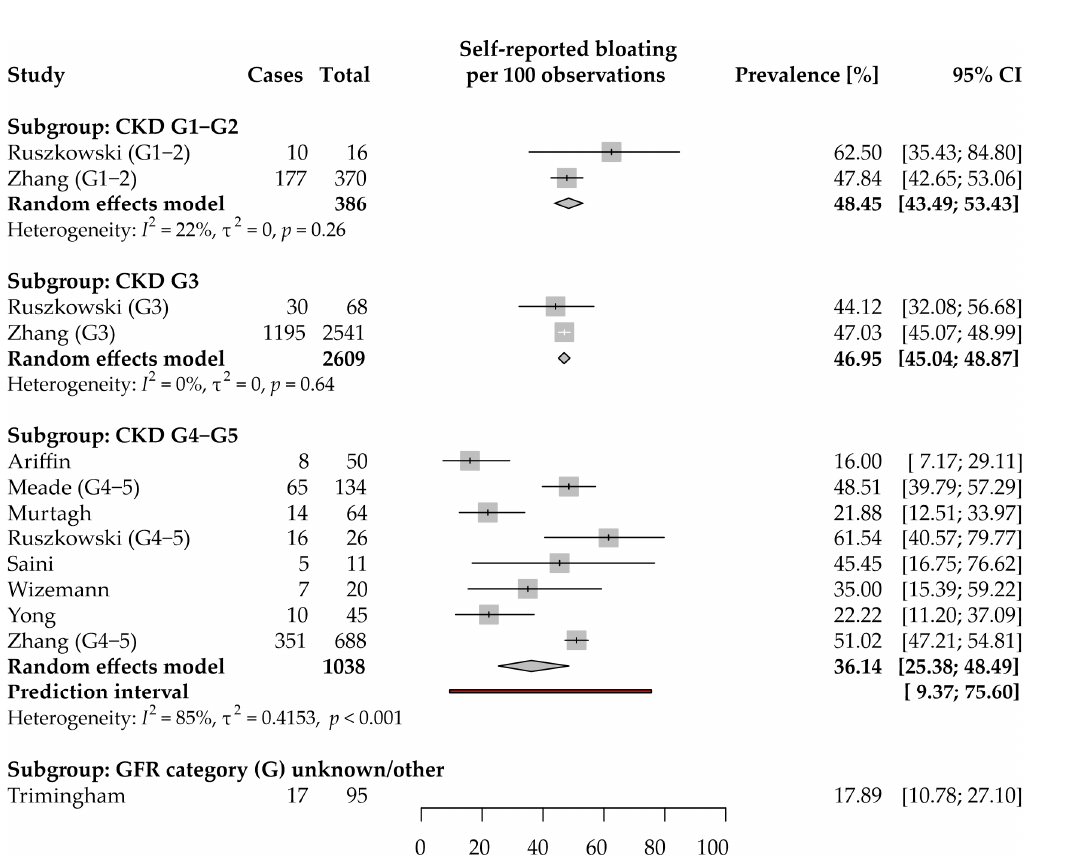
Figure 5. Forest plot with pooled point prevalence estimates for self-reported bloating in chronic kidney disease by stages.